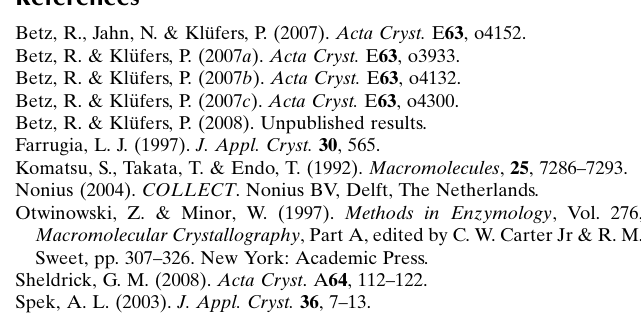
Experimental Crystal data